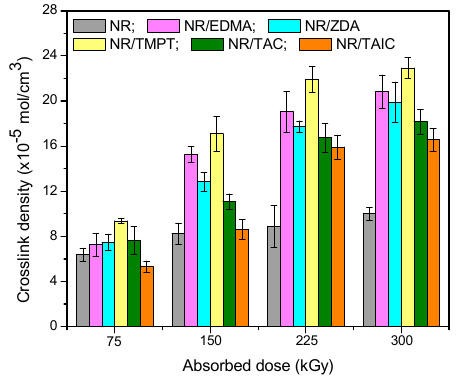
Figure 2. Effects of absorbed dose and PFMs type on cross-link density.